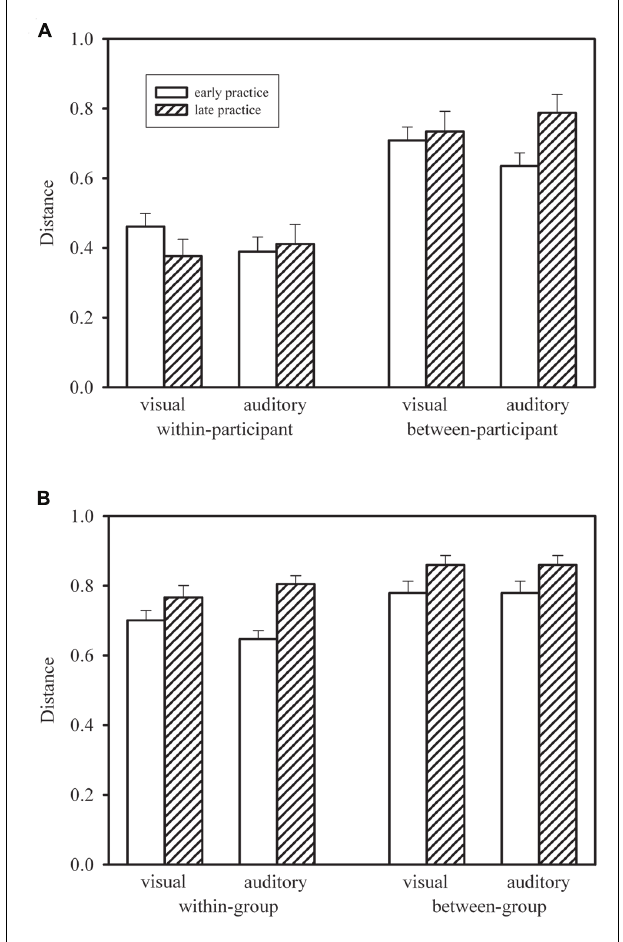
FIGURE 4 | Mean within-participant distances in the visual and auditory groups, during early and late practice, compared with re-sampled mean between-participant distances (A), and mean within-group distances compared with mean between-group distances (B). Error bars show standard errors of the means. For between-participant distances (A) , error bars show standard deviations of the means of randomly re-drawn